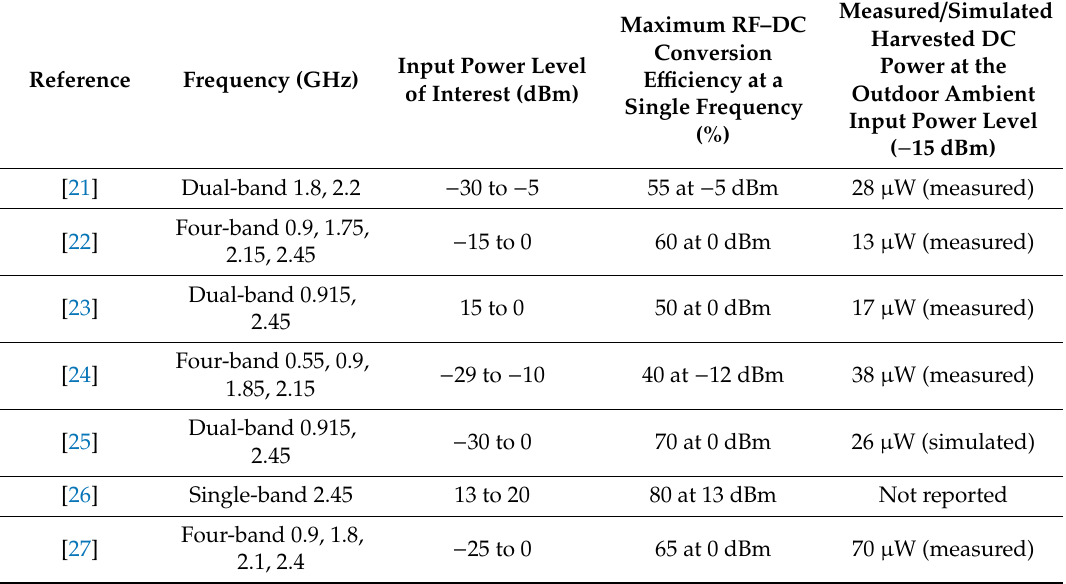
Table 1. Comparison of harvesting systems at di ff erent frequency bands. RF, radiofrequency; DC, direct